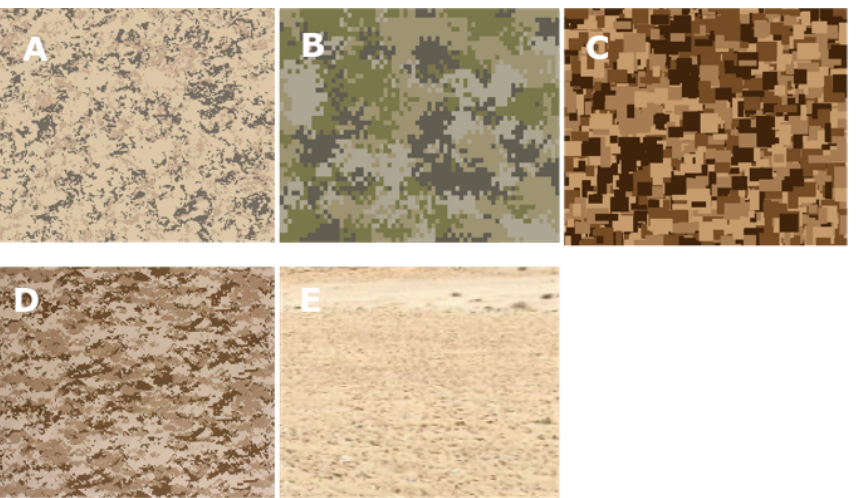
Figure 21. Camouflages analyzed in the desert area: ( A ) generated with created CammoGenerator , ( B ) generated with Camouflage Generator [15], ( C ) generated with Digital Cammo Generator [16], ( D ) MARPAT camouflage (Marine pattern) Digital Desert Camouflage [25], ( E ) tested section of terrain.